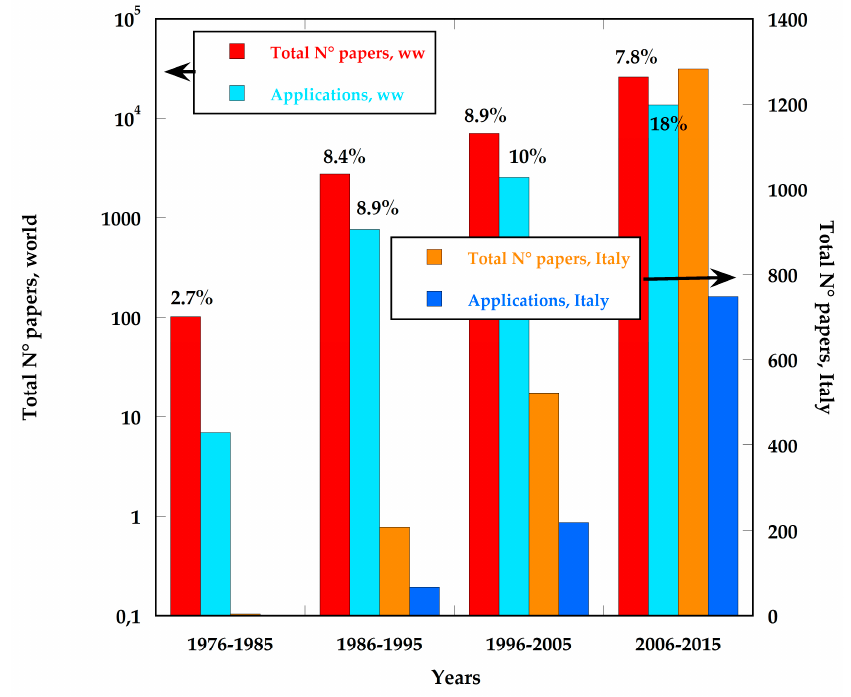
Figure 1. Scientific and technical papers concerning the development of sensor devices and of related applications, published in the period 1976–2015, both worldwide and in Italy. At the top of the columns, the ratio (%) of citations of Italian papers to the total (ww) number of citations (self-citations excluded) is reported, for each category considered.